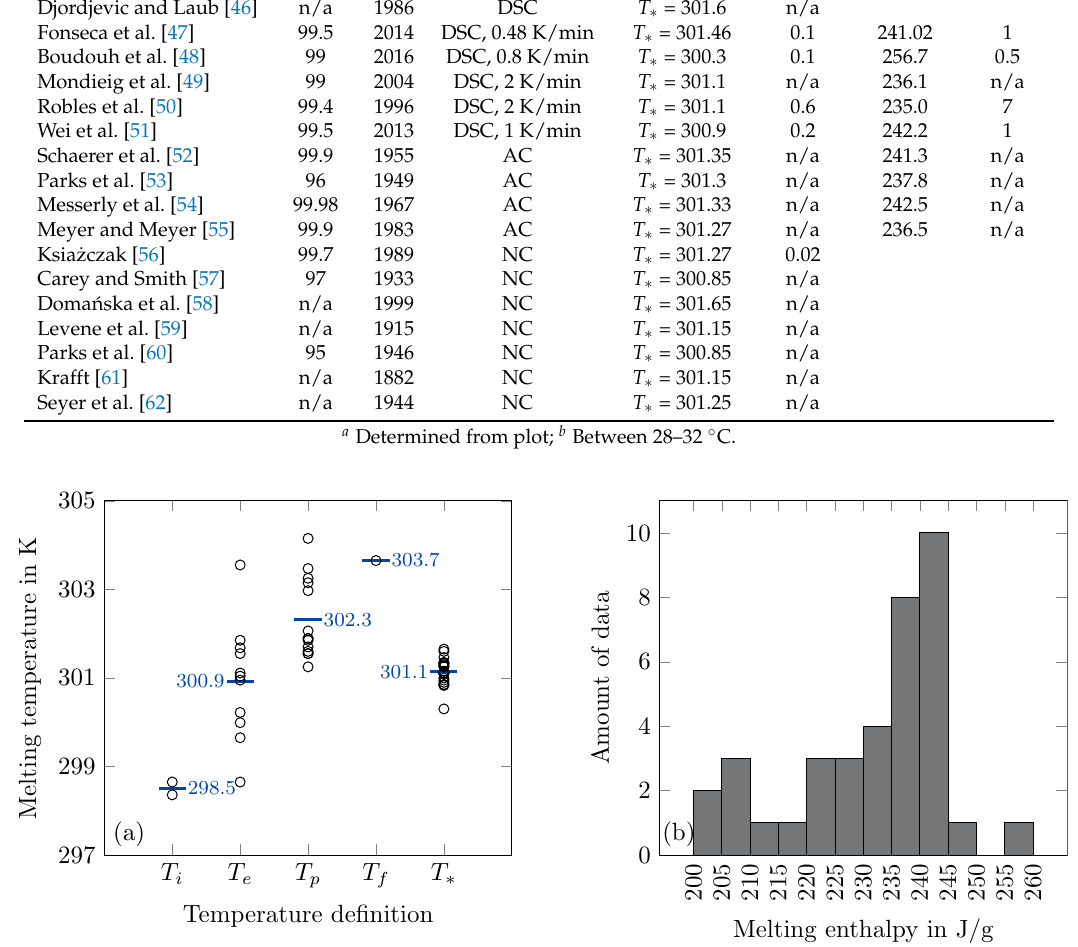
Figure 1. Summary of melting temperature ( a ) and enthalpy ( b ) data from the literature. The melting temperature ( a ) is arranged according to the given temperature definition. The blue bars represent the mean value of the data at each temperature definition. The melting enthalpy data ( b ) are presented in the histogram according to their